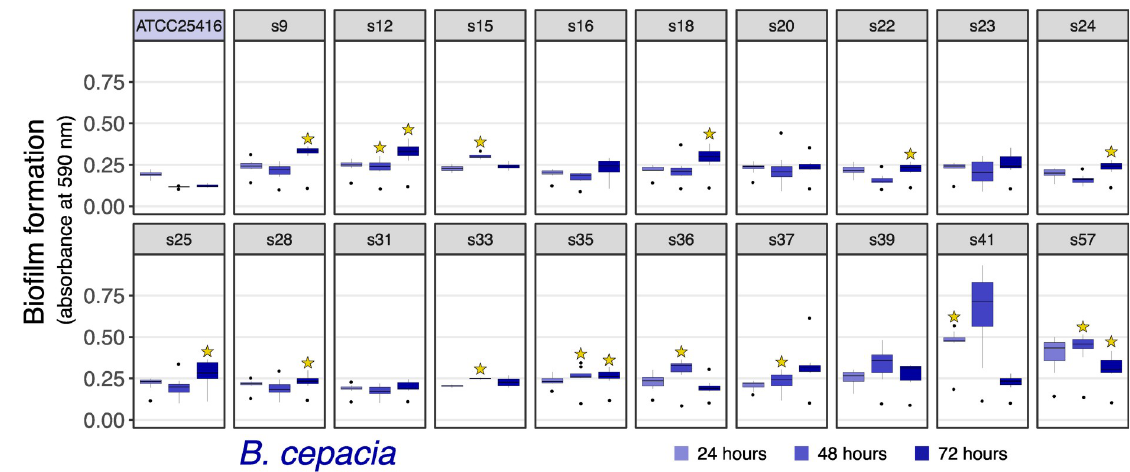
Fig 10. Biofilm formation of B . cepacia . Based on crystal violet assay. Boxplots of each timepoint’s absorbance values are plotted for each (n = 8 within each boxpot). Plotted are means with standard errors as error bars (n = 8). Stars indicate < 0.05 adjusted p-value from two- sided t-tests against the reference strain (adjusted by Bonferonni